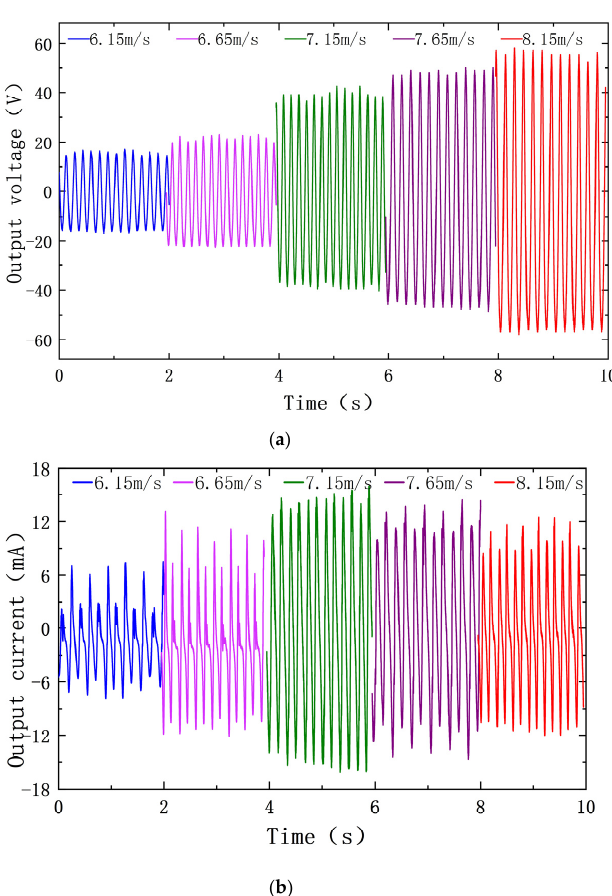
Figure 9. Output time-domain curve under different wind speeds before and after the jump at d 0 is 34 mm: ( a ) the PEH output voltage; ( b ) the EEH output current. Figure 10 shows the Fourier change curve of the output voltage and output current of the PEH and the EEH when d 0 is 34 mm. From Figure 10, it can be observed that the PEH has no significant changes except for changes in the voltage of the amplitude- frequency curve before and after the jump change. The vibration is a single-frequency vibration corresponding to the first main frequency. The amplitude-frequency curve of the EEH before the jump is a multifrequency form that appears at the same time at the same time of the first and second main frequencies. Near the jump point, the first main frequency range value is reduced. This phenomenon often occurs in strongly nonlinear systems. The vibrator of the EEH is affected by the nonlinear magnetic force of two magnetic springs and a moving permanent magnet. The magnitude of d 0 affects the magnitude of the nonlinear force of the permanent magnet on the vibrator. The decrease in d 0 causes the vibrator to exhibit stronger nonlinear characteristics. In the nonlinear system, the nonlinear natural frequency is related to the vibration amplitude. With the increase in the vibration amplitude, the natural frequency also increases, and the amplitude jump occurs at the frequency corresponding to the maximum displacement response. ( a ) ( b ) Figure 10. Fourier transform curve under different wind speeds before and after the jump at d 0 is 34 mm ( a ) the PEH ( b ) the EEH.